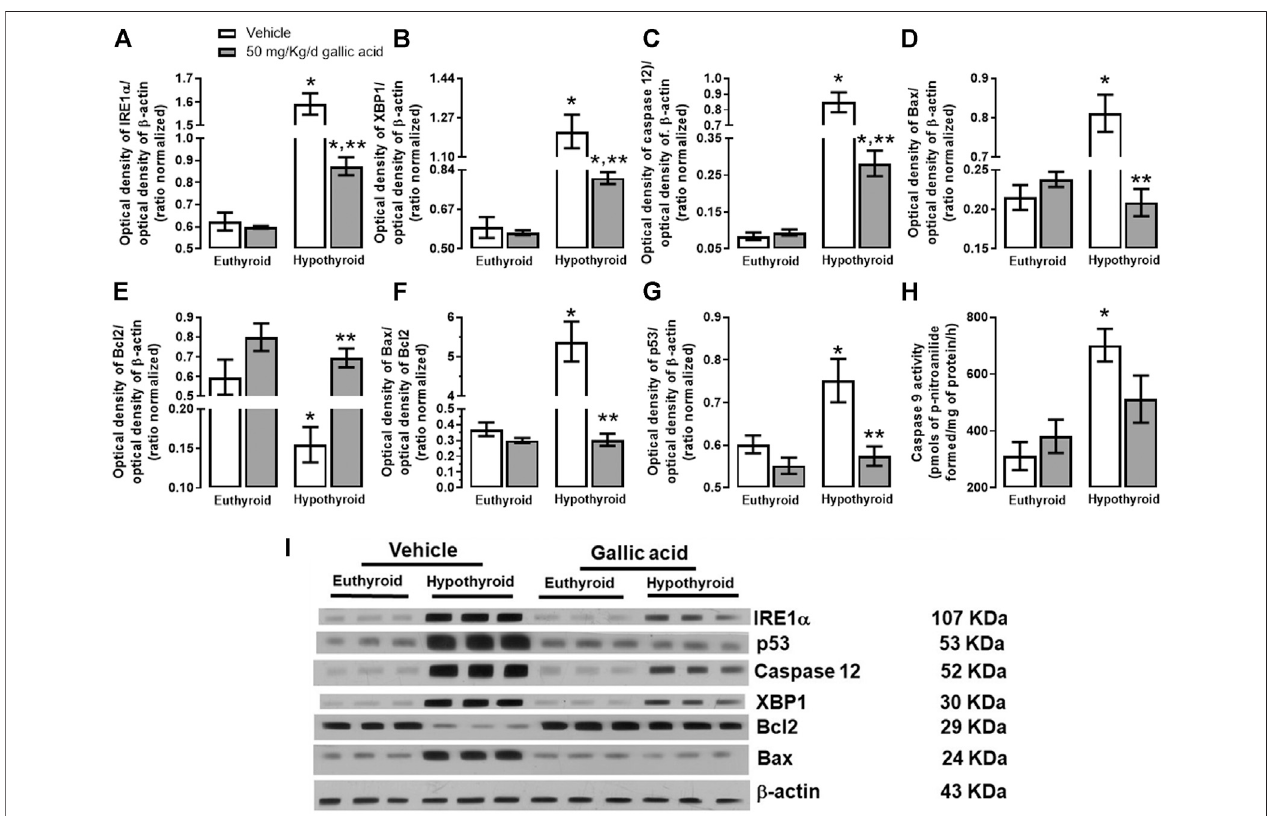
FIGURE 4 | Effect of gallic acid on hypothyroidism-induced activation of the endoplasmic reticulum stress pathway related to neuronal damage in adult rats ’ hippocampus.TheproteinexpressionevaluatedwereIRE1 α (A) ,XBP1 (B) ,caspase12 (C) ,Bax (D) ,BCl2 (E) ,p53 (G) ,andtheBax/Bcl2ratio (F) . (H) showstheactivity of caspase 9, and panel I, the blot of the protein expression. Values represent the mean ± SEM. (*) p < 0.05 vs. Euthyroid + vehicle group. (**) p < 0.05 vs. hypothyroid + vehicle group.